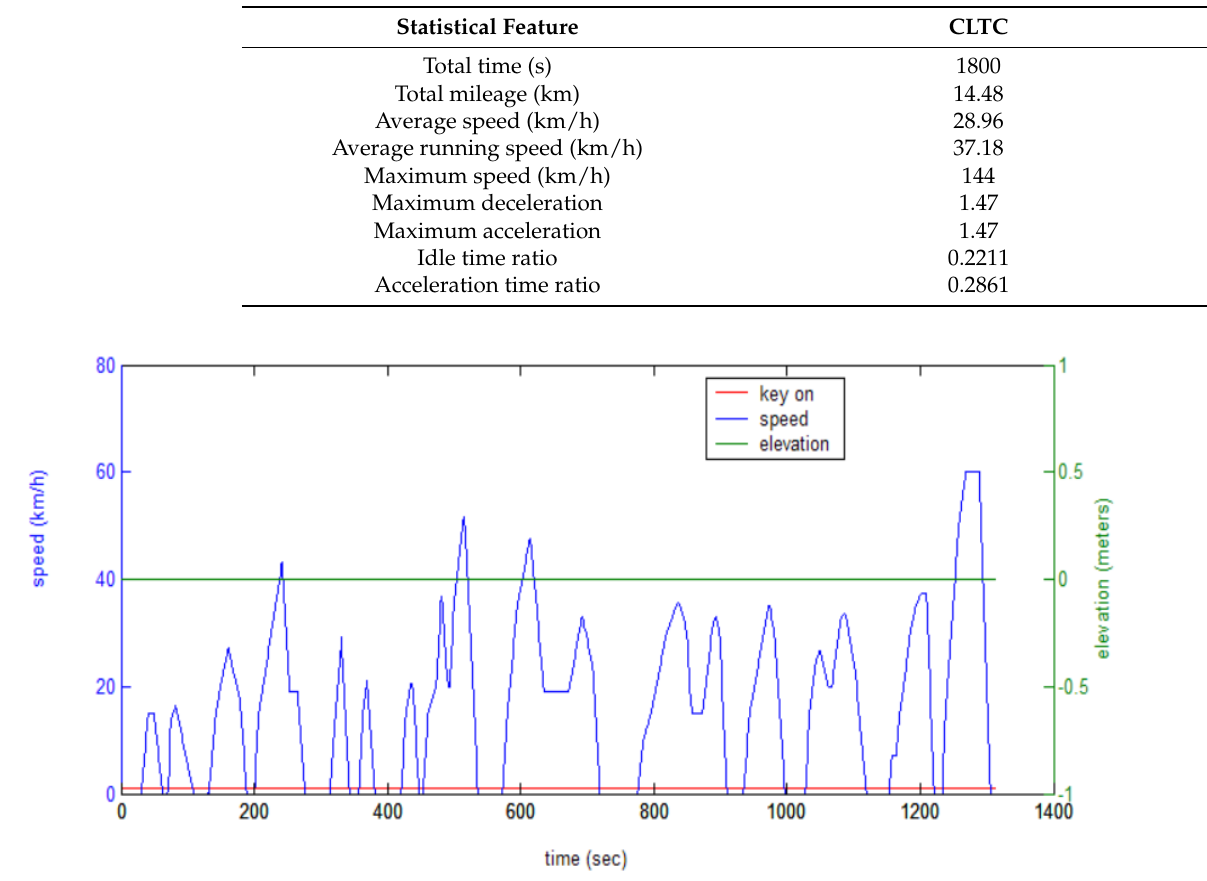
Figure 8. CLTC-C driving condition diagram.